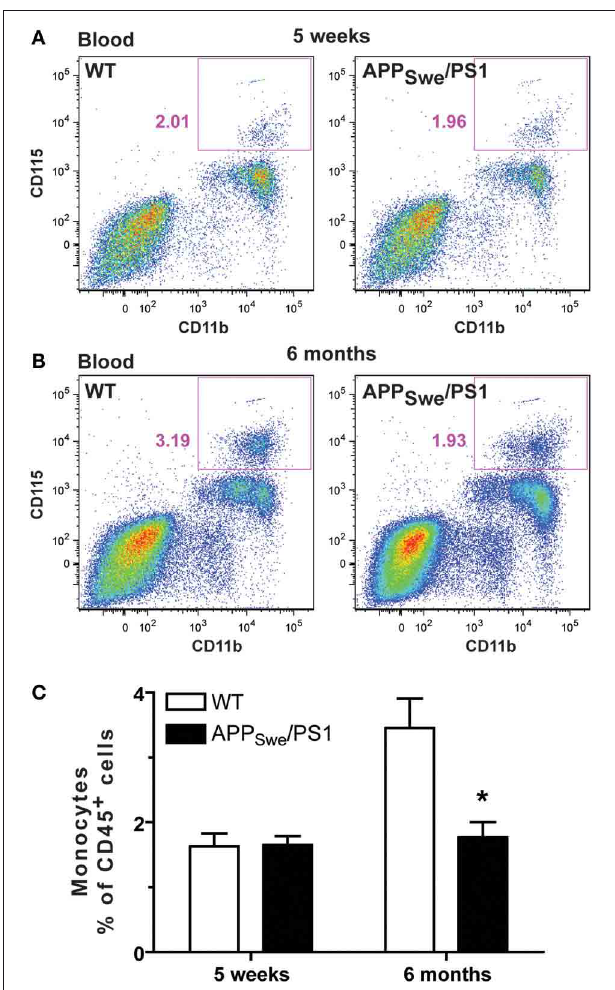
FIGURE 5 | Monocyte levels are drastically diminished in 6-month-old APP Swe /PS1 mice. Circulating monocyte numbers were determined by FACS analysis within the population of leukocytes (CD45 + ) in the blood of WT and APP Swe /PS1 mice at 5 weeks and 6 months of age. Monocytes were characterized by CD11b and CD115 expression and were quantified within the population of CD45 + cells. At 5 weeks of age, WT and APP Swe /PS1 mice exhibited similar levels of monocytes (A and C) . In contrast, APP Swe /PS1 mice had fewer monocytes than WT mice at 6 months of age (B and C) . Results are expressed as the Mean ± SEM; n = 7–8; Student’s t -test; ∗ p < 0 . 05; ∗ vs. WT at the same